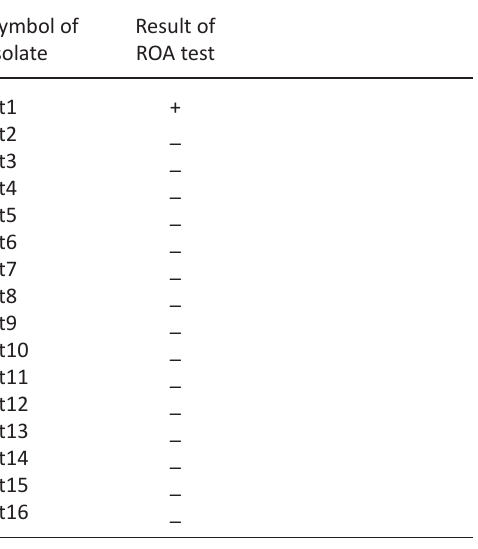
Table 2. Lipase activity on ROA plate test for isolates Staphylococcus haemolyticus Symbol of